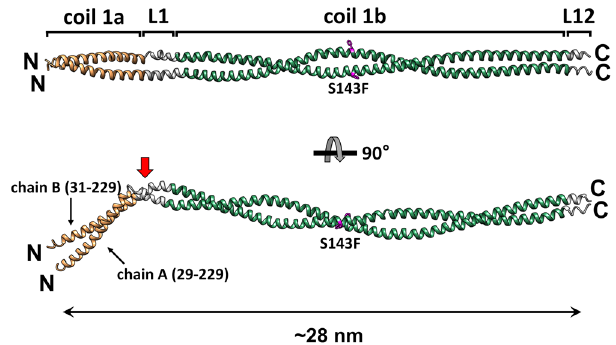
Fig. 1 Crystal structure of the S143F mutant lamin 300 fragments (residues 1 – 300). The asymmetric unit structure of the S143F mutant lamin fragment consists of two chains in a parallel coiled-coil arrangement. The ordered residues and the length of the coiled-coil dimer are indicated. Coil 1a is in yellow, linkers L1 and L12 are in gray, and coil 1b is in green. The kinks are in linker L1, as indicated by the red arrow. The Phe143 residues are colored magenta in stick